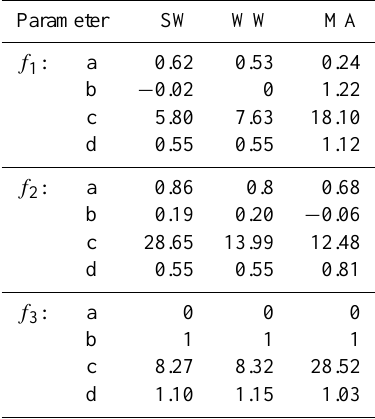
Table A1. The parameters for the factors f 1 , f 2 and f 3 in the carbon allocation scheme (Eq. A2) for spring wheat (SW), winter wheat (WW) and maize (MA).